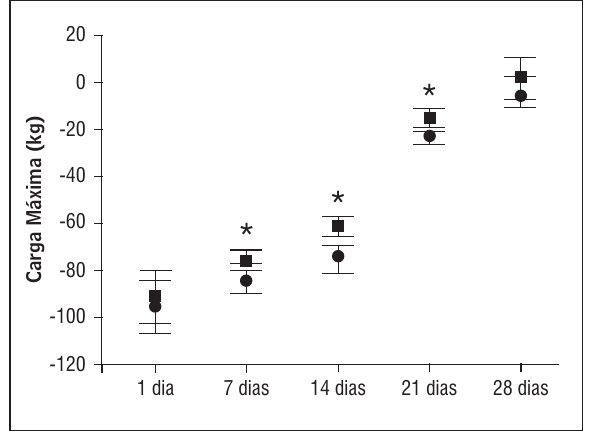
Figura 3 - Valores de IFC dos grupos controle e experi- mentais (valores médios ± desvio padrão). (*) Diferenças significantes, p < 0,05 Fonte: Dados da